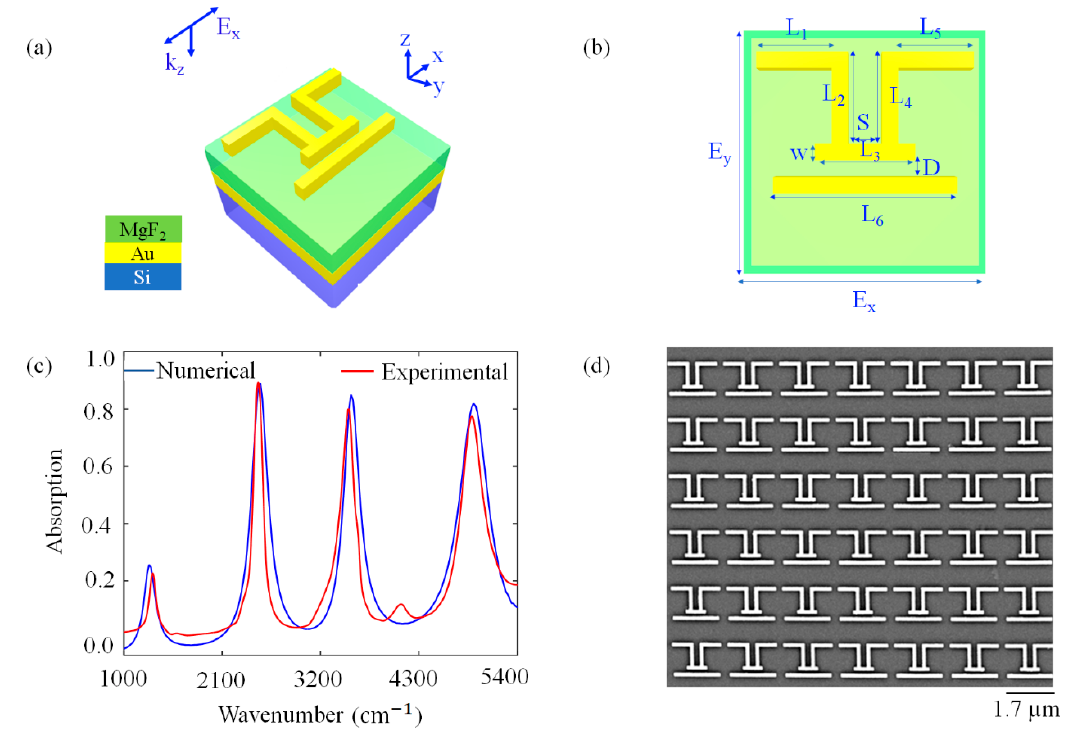
Figure 1. Schematic view of designed structure; ( a ) 3D view of the unit cell and ( b ) top view. ( c ) Simulated and experimental absorption spectrum of the PA under x-polarized illumination source. The results are nearly identical in terms of bandwidth and resonance frequency. ( d ) SEM image of the fabricated nanoantenna arrays that gives the optical responses presented in ( c ).